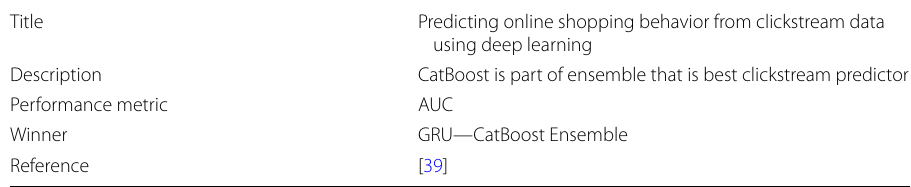
CT-based machine learning model to predict the Fuhrman nuclear grade of clear cell renal cell carcinoma Description Classify kidney cancer images into instances of high-grade or low-grade cancer, presents opportunities for research at Big Data scale Performance metric Used only CatBoost Winner N/A Reference diseases spread prediction in tropical areas by machine learning methods ensembling and spatial analysis techniques Description Use CatBoost to predict spread of dengue fever Performance metric Mean absolute error Winner LSTM and XGBoost ensemble Reference Performance analysis of boosting classifiers in recognizing activities of daily living Description Compare CatBoost with XGBoost in ability to identify human physical activity types from sensor data Performance metric f-measure Winner Friedman stochastic gradient boosting, ada-decision trees Reference